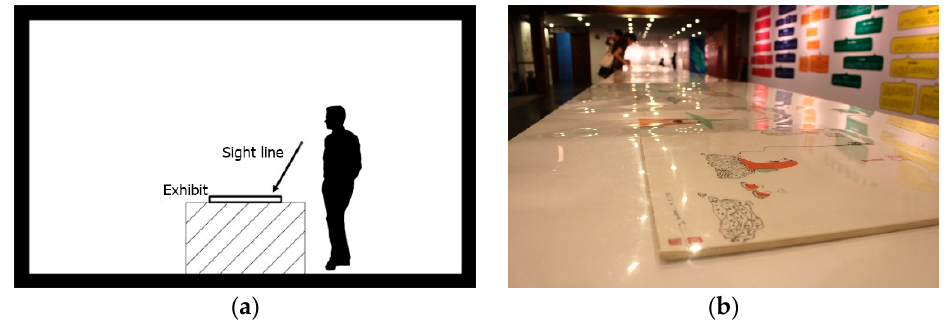
Figure 2. Flat spread display ( a ) Schematic diagram of exhibit arrangement; ( b ) Example: Guangdong Museum of Art.